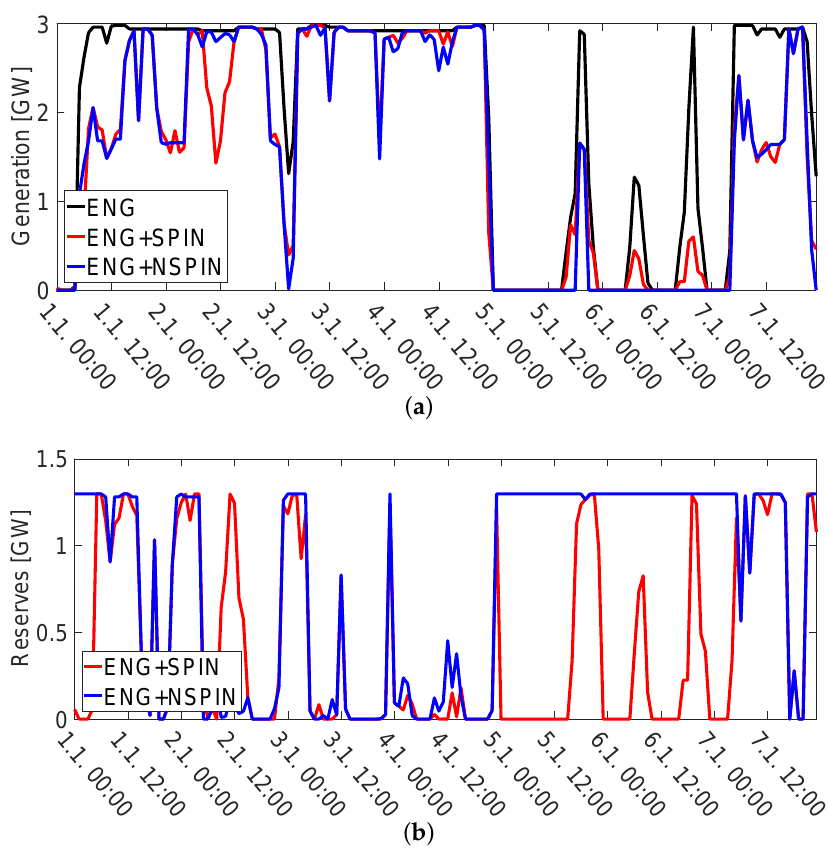
Figure 3. Illustrations of the operation of CCGEs in electricity and reserve production. ( a ) Hourly generation for a week including all the cases with gas engines; ( b ) Hourly upward reserve capacity of gas engines for the same time